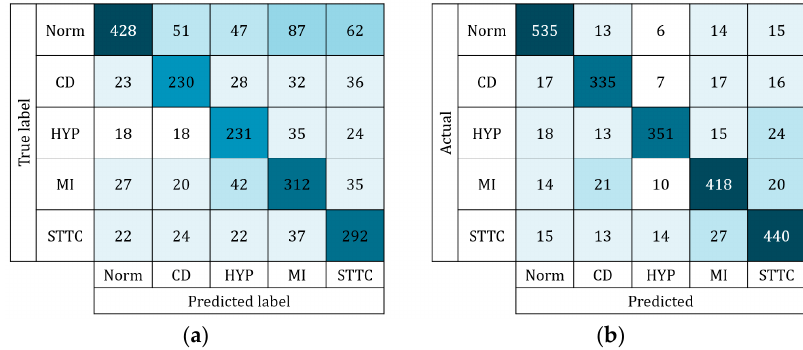
Figure 10. Confusion matrix: ( a ) LSTM model and ( b ) ResNet34 model.